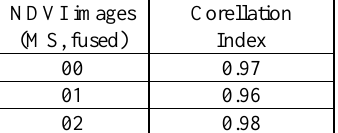
Table 3. Correlation coefficient values between the NDVI-MS and NDVI-fused image.